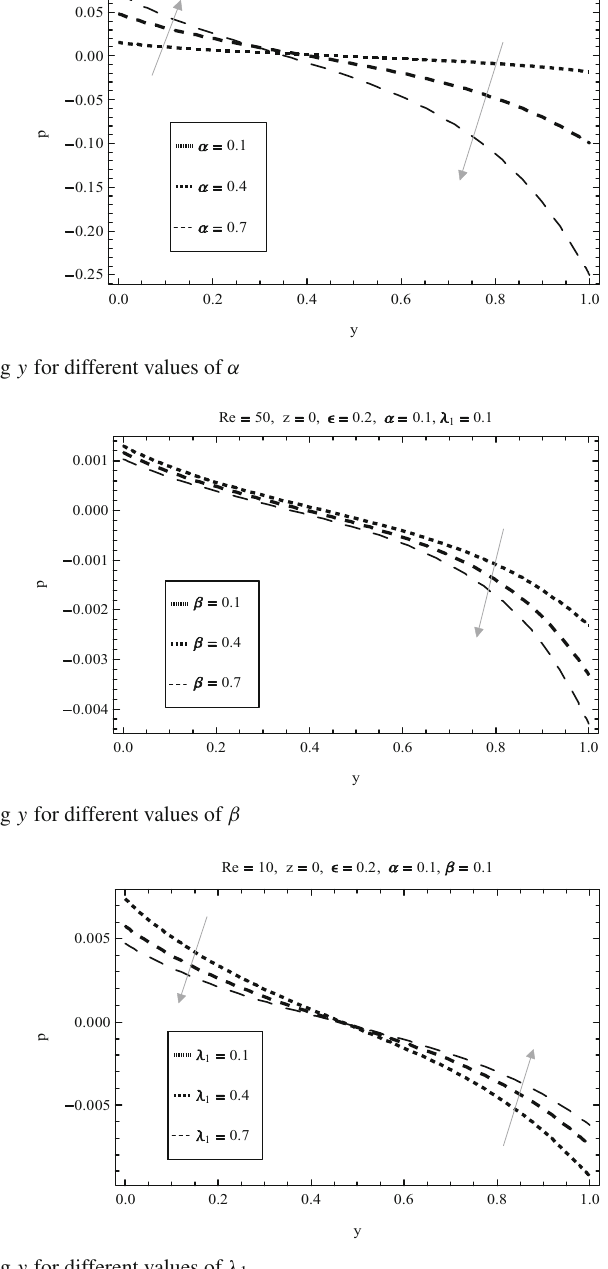
Figs. 16 and 17 that there is a drop in adverse pressure from y = 0 to about y = 0 . 5, and then, onwards, there is enhancement in favourable